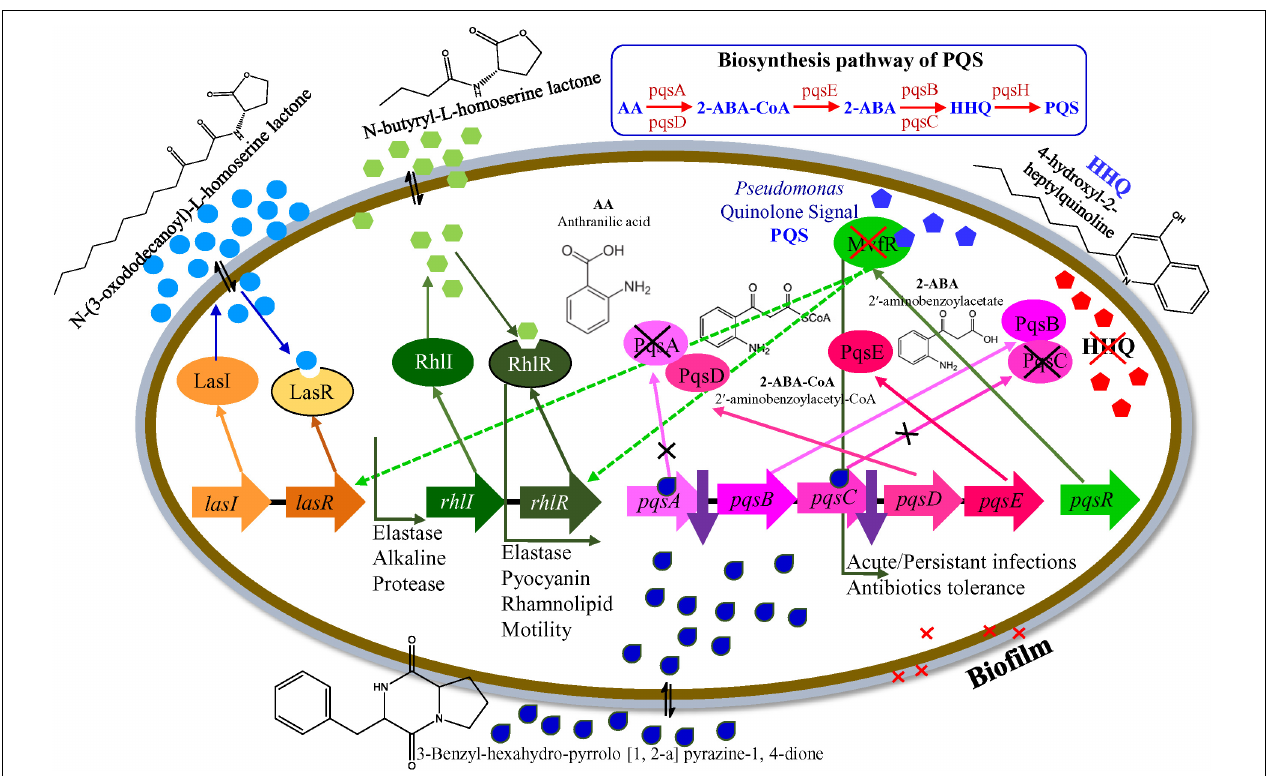
FIGURE 7 | A hypothetical model for the transcriptional regulation of QSI in P. aeruginosa PAO1.